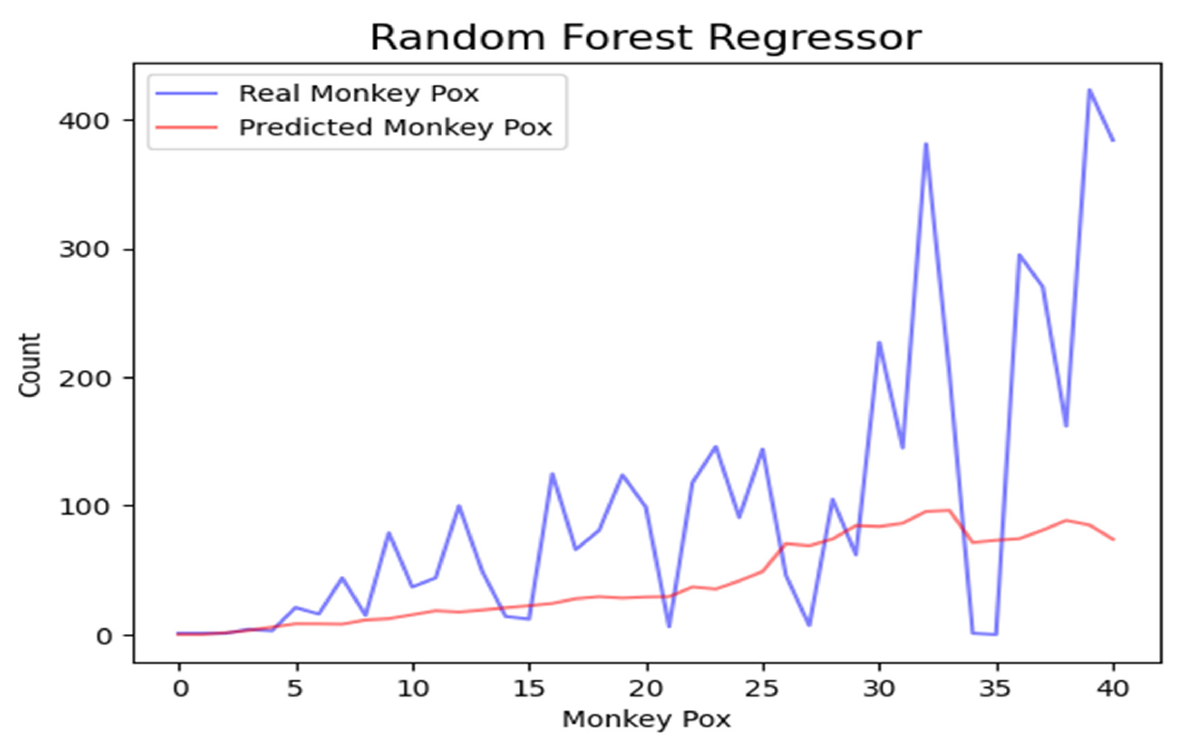
Figure 10. Time Series of Gradient Boost Algorithm.